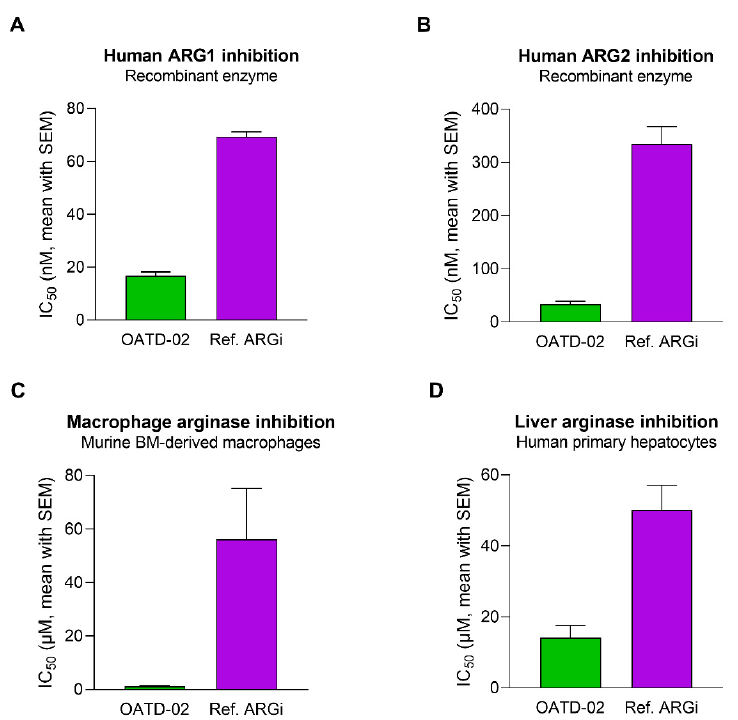
Figure 1. OATD-02 is a highly potent ARG1 and ARG2 inhibitor. In vitro enzymatic assays using recombinant human ARG1 ( A ) and ARG2 ( B ) enzymes mimic the extracellular activity of OATD-02, while cell-based assays performed with murine M2-polarized BMDMs ( C ) and platable human primary hepatocytes ( D ) reveal its potential in inhibiting intracellular arginases. Reference ARG inhibitor (Ref. ARG1) was used for comparative purposes. 3.2. OATD-02 Showed Superior Activity in Combination with ICI and IDO Inhibitor. OATD-02 was tested in the syngeneic CT26 model of colorectal carcinoma along with the ref. ARGi (Figure 2). Both compounds were dosed twice daily at 100 mg/kg by oral gavage, starting from day 1 post-inoculation. We have shown that monotherapy with OATD-02, in contrast to the ref. ARGi with a predominant extracellular activity, significantly inhibited the growth of CT26 tumours, which are characterized by relatively high immune cell infiltration. A statistically significant effect of OATD-02 was observed from day 12 post-inoculation and was sustained until the end of the experiment (Figure 2A, final TGI 48%, p = 0.0033 for OATD-02 vs. final TGI 28%, p = 0.4390 for ref. ARGi). Despite higher oral bioavailability of the ref. ARGi (Figure 2B), OATD-02 exhibited higher pharmacodynamic effects by increasing the concentrations of endogenous plasma L -arginine up to 6.7-fold vs. 3.3-fold change for the ref. ARGi, as measured at 6 h after the last dosing. These observations were reflected in the tumours (Figure 2C)—within the first 6 h post-dosing, OATD-02 caused a significant increase of L -arginine (up to 6.9-fold vs. 3–6-fold change for ref. ARGi) detected in tumour homogenates. These characteristics represent optimal drug-like properties of OATD-02 at this regiment of dosing. Encour-